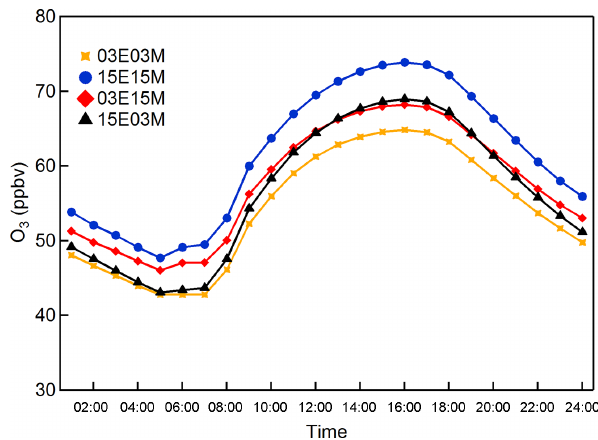
Figure 4. Averaged diurnal variations in surface O 3 over CEC de- rived from four simulation